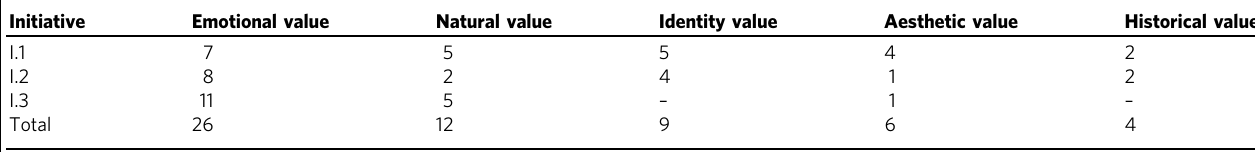
Authors ’ own work.